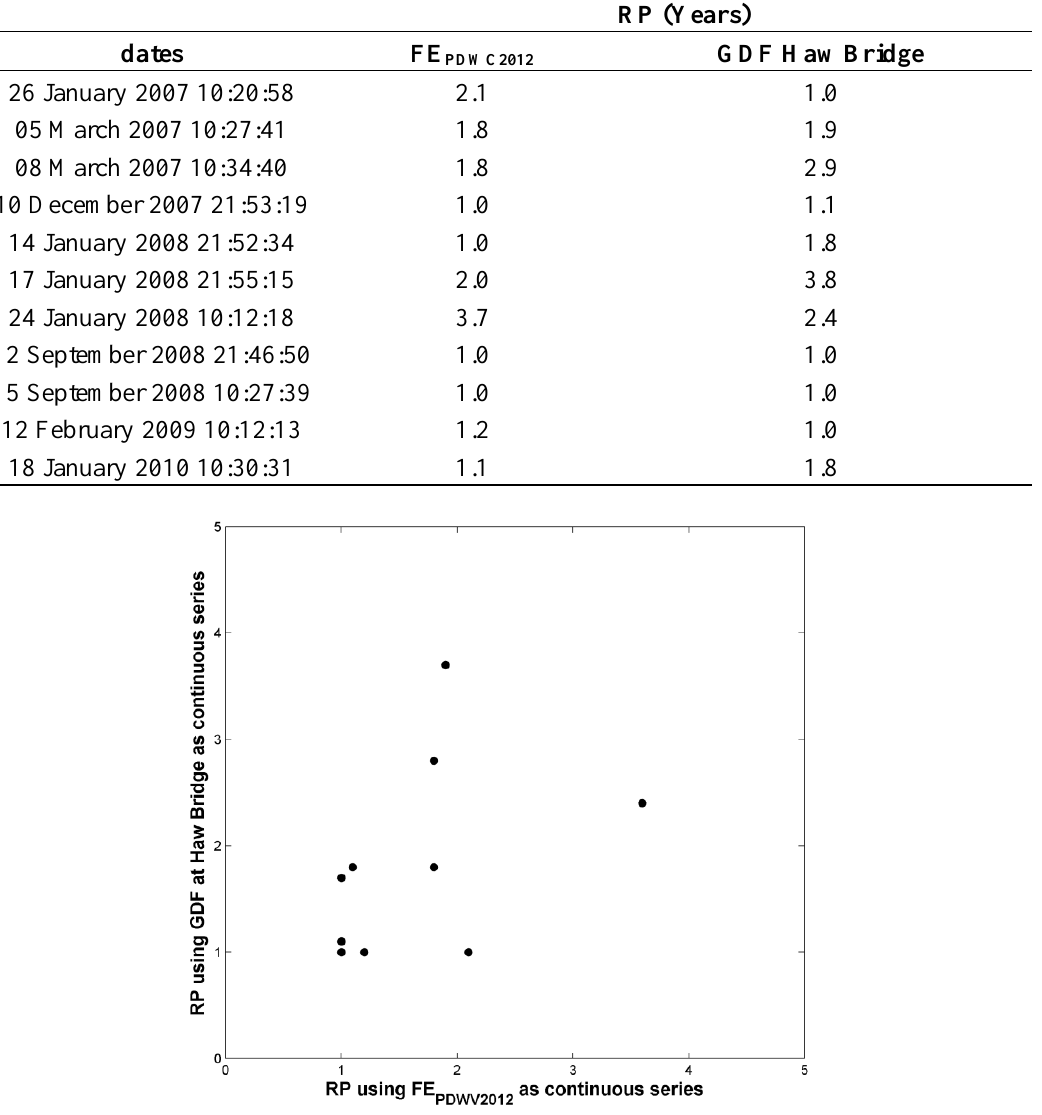
Figure 7. Scatter plots of RPs obtained using as time continuous series FE PDWC2012 and GDF at Haw